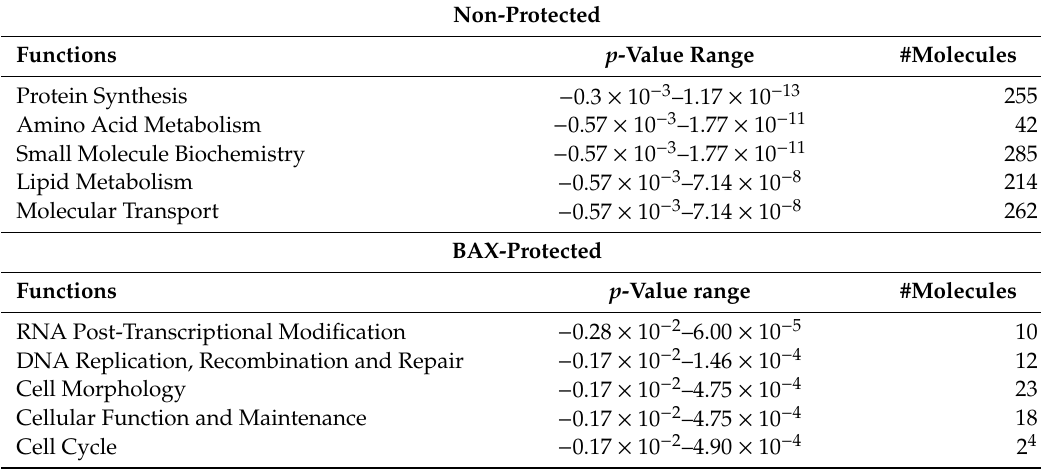
Table 1. Top molecular and cellular functions identified by Ingenuity Pathway Analysis in the protection and non-protection subgroup during malignant